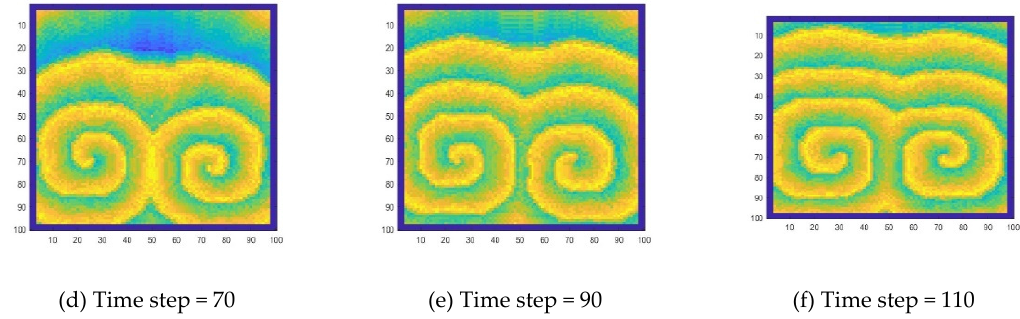
Figure 12. Propagation of spiral wave simulating B-Z reaction by CA.